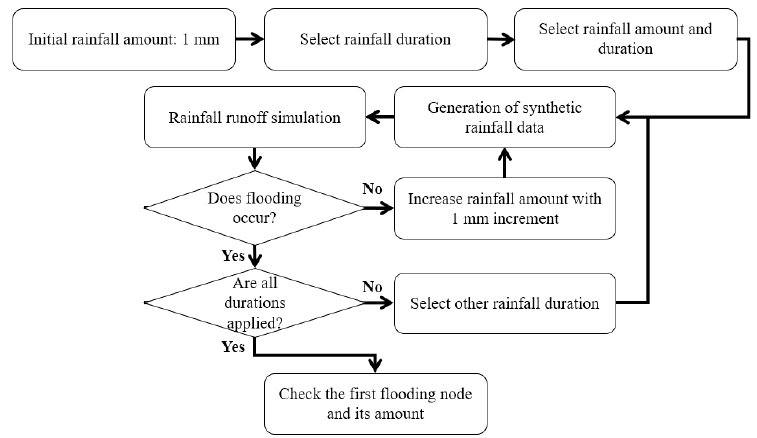
Figure 3. The process for finding the first flooding nodes.